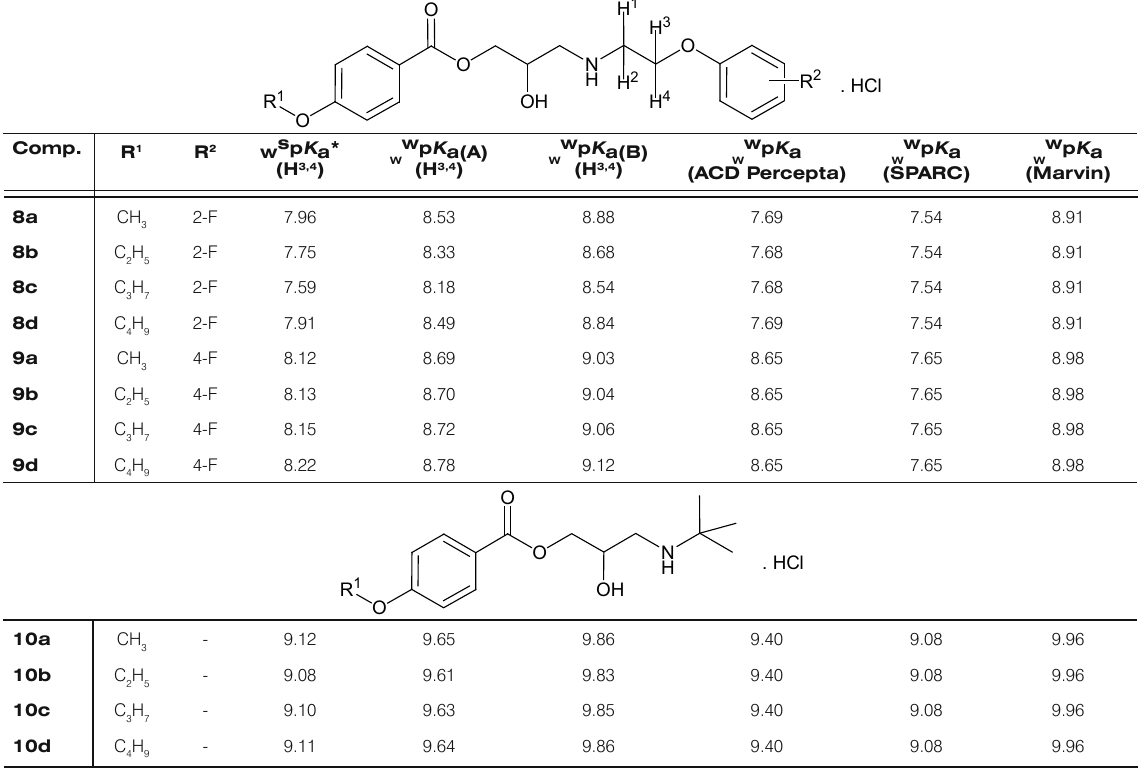
(cid:3)(cid:89)(cid:68)(cid:79)(cid:88)(cid:72)(cid:86)(cid:3)(cid:68)(cid:87)(cid:3)(cid:87)(cid:75)(cid:72)(cid:3)(cid:76)(cid:81)(cid:288)(cid:72)(cid:70)(cid:87)(cid:76)(cid:82)(cid:81)(cid:3)(cid:83)(cid:82)(cid:76)(cid:81)(cid:87)(cid:3)(cid:11) wsp K a (cid:13)(cid:12)(cid:15)(cid:3)(cid:287)(cid:81)(cid:68)(cid:79)(cid:3)(cid:70)(cid:82)(cid:85)(cid:85)(cid:72)(cid:70)(cid:87)(cid:72)(cid:71)(cid:3)(cid:89)(cid:68)(cid:79)(cid:88)(cid:72)(cid:86)(cid:3)(cid:82)(cid:73)(cid:3)(cid:83) K a